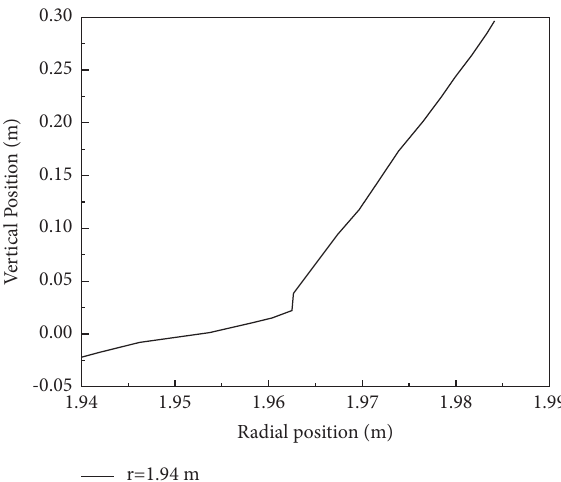
Figure 16: Vertical displacement of soil particles directly below the rammer.